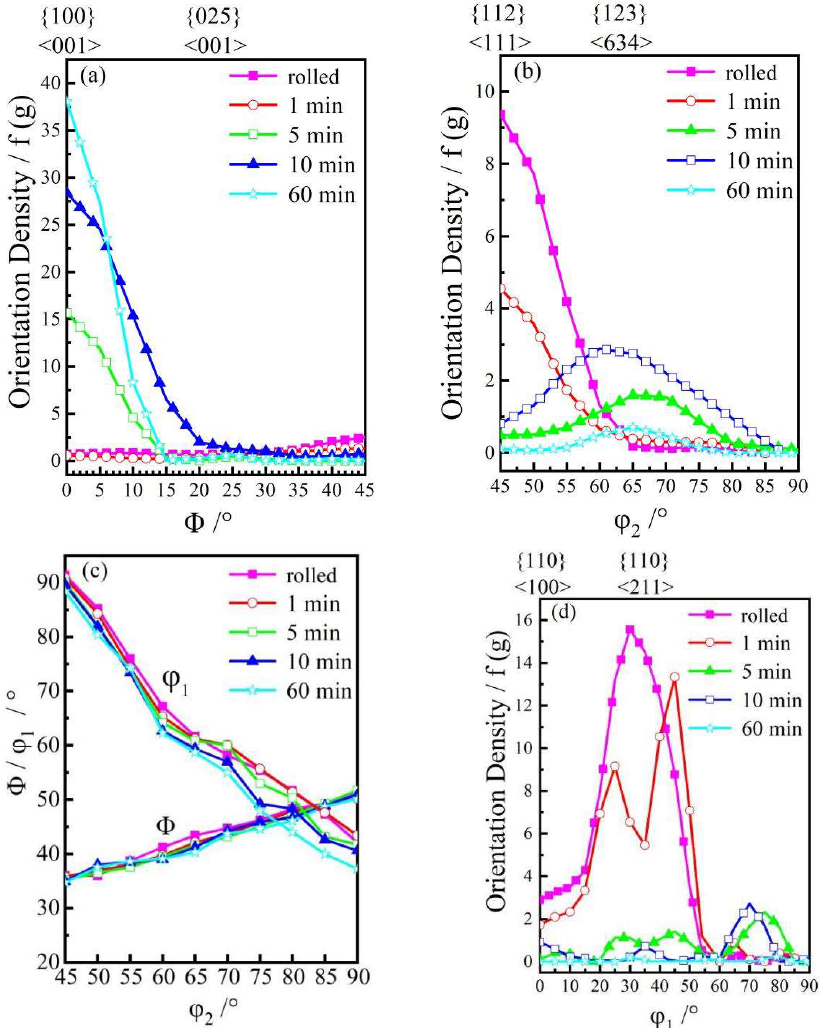
Figure 8. Texture orientation density of the copper foil. ( a ) (0°,0° → 45°,0°) fiber; ( b ) β-fiber; ( c ) Posi- tion of β-fiber; ( d ) α-fiber.